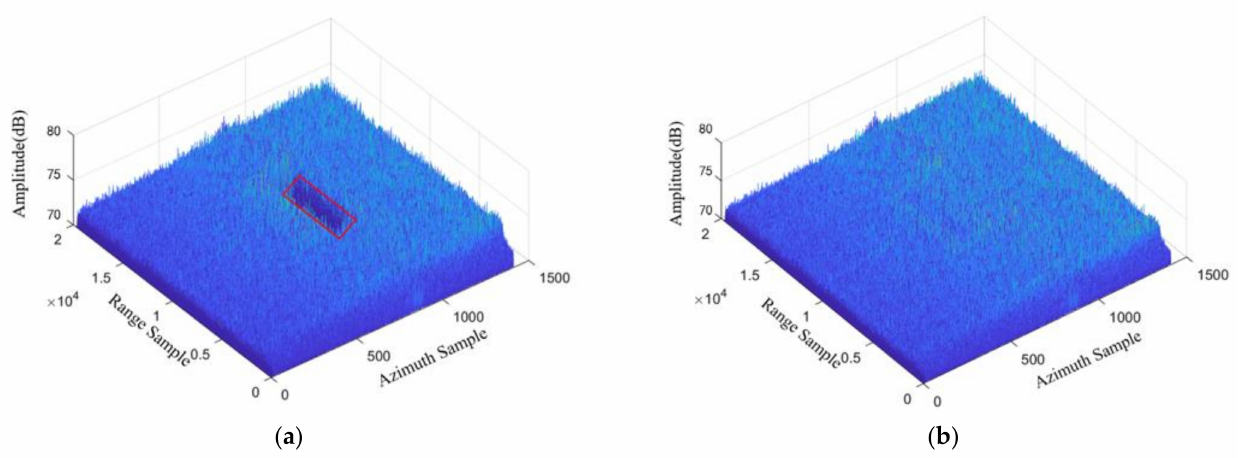
Figure 10. The 3-dimensional diagram in the range-frequency and azimuth-time domain after RFI mitigation: ( a ) FNF; ( b ) the proposed